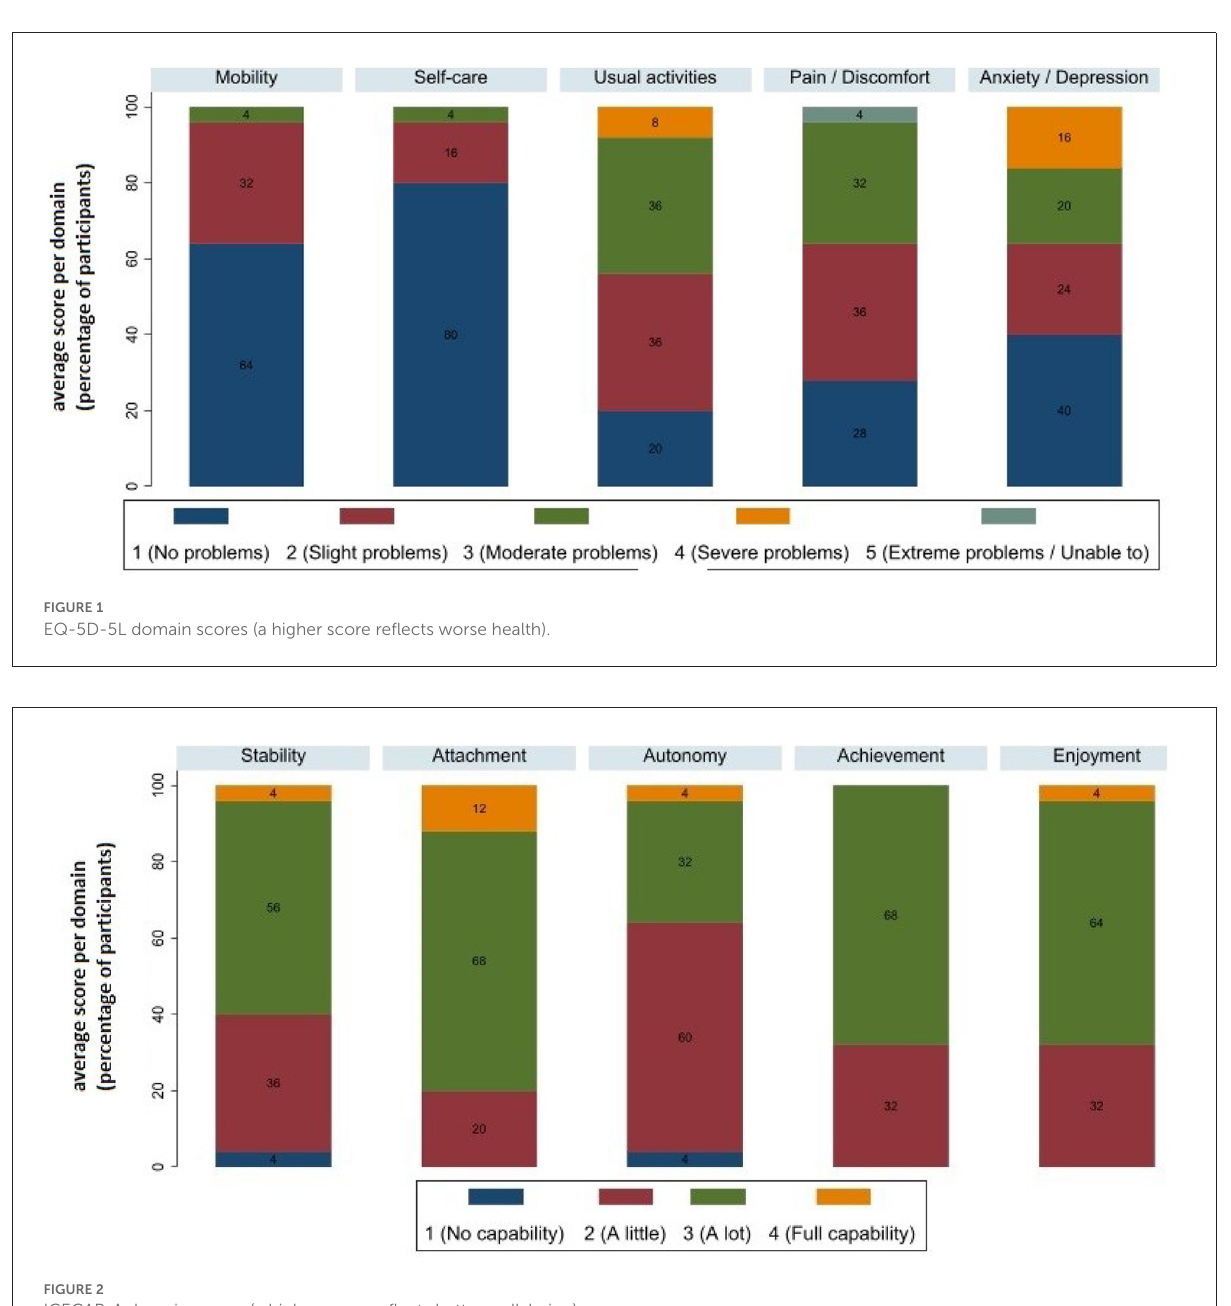
FIGURE2 ICECAP-A domain scores (a higher score reflects better